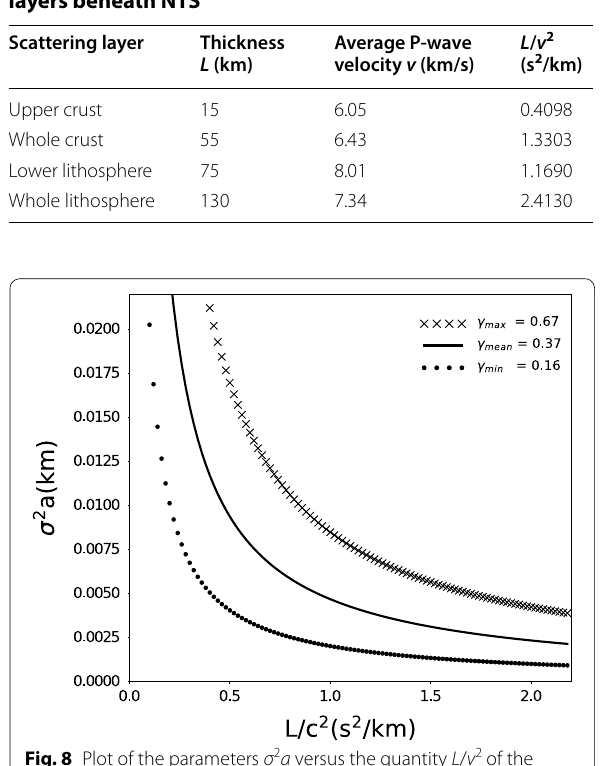
Table 2 Correlation lengths a for velocity perturbations σ Scattering